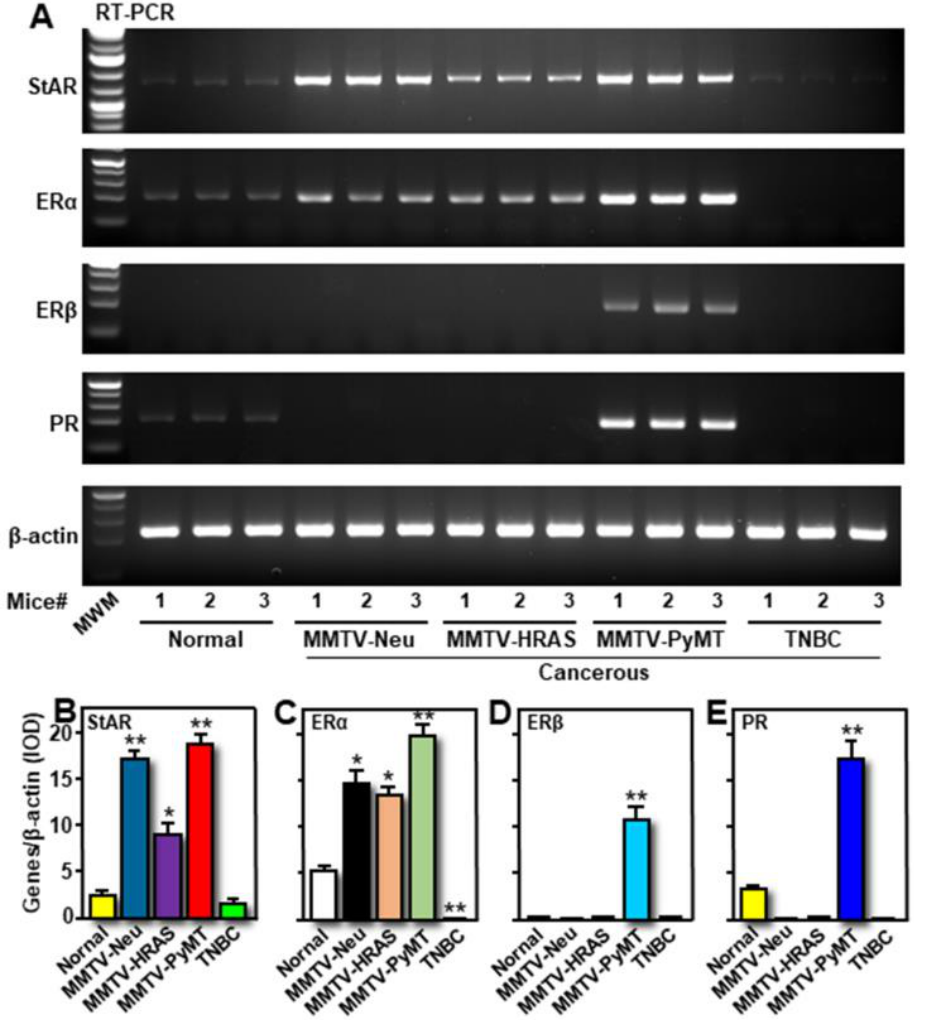
Figure 3. Expression of StAR, ER α , ER β , and PR mRNAs in Tg mice breast tumors from MMTV-Neu, MMTV-HRAS, MMTV-PyMT, and TNBC, and in normal mammary tissue. Both non-cancerous and cancerous breast tissues were subjected to total RNA extraction using either TRIzol reagent or PureLink RNA mini kit, and mRNA levels were determined by semi-quantitative RT-PCR ( A ), as described under Materials and methods . Representative gel images illustrate expression of StAR, ER α , ER β , and PR mRNAs in different mouse groups (three independent mice # 1, 2, and 3 in each category). Integrated optical density (IOD) values for StAR ( B ), ER α ( C ), ER β ( D ), and PR ( E ), in each band, were quantified and normalized with the corresponding β -actin bands, and combined data are presented (N = 3). *, p < 0.05; **, p < 0.01 vs. Normal. MWM, molecular weight marker.